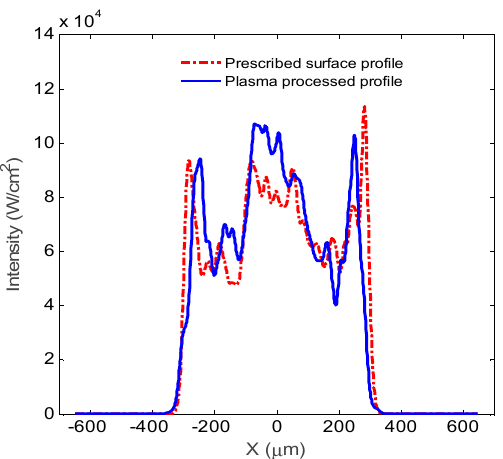
Figure 9. One-dimensional distribution of the focal spot. The non-uniformity is scaled by the focal spot contrast in a circle with the energy included. The relationship between the energy proportion and the diameter from the centroid are given in Figure 10. The 90% encircled energy radius values for the prescribed surface and plasma-fabricated surface are 374 and 363 µ m, respectively. The energy radius deviation is 11 µ m, which is less than the specification of 15 µ m.